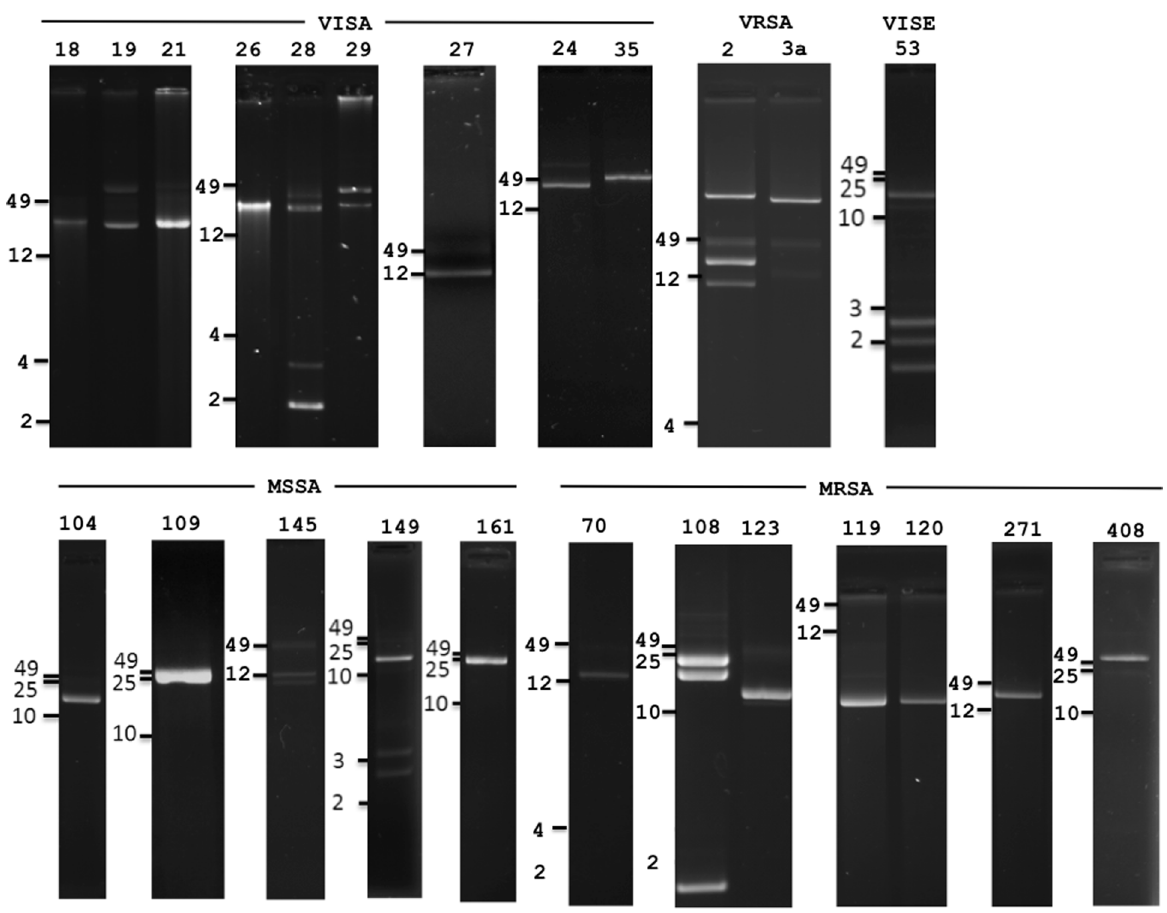
Figure 1. S.aureus extra-chromosomal DNA isolated from VISA, VRSA, MRSA, VISE and MSSA strains. Extra-chromosomal DNA from S. aureus strains was separated by electrophoresis on a 0.7% agarose gel and stained with ethidium bromide. Numbers on top designate NRS or VRS strain designations from the NARSA repository (http://www.narsa.net/content/staphLinks.jsp): NRS numbers 18, 19, 21, 24, 26, 27, 28, 29, and 35 are VISA strains; VRS 2 and 3a are VRSA strains; NRS 70, 108, 119, 120, 123, 271 and 408 are MRSA strains; 53 is a VISE; and 104, 109, 145, 149, and 161 are MSSA strains. Separate 0.7% agarose gels profiling the extra-chromosomal isolations were combined; numbers next to the black dashes on the left next indicate the position of molecular weight standards in